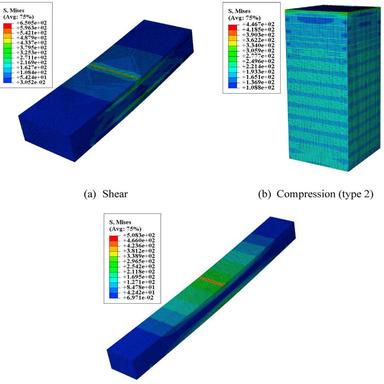
Stress contours corresponding to Class 2.